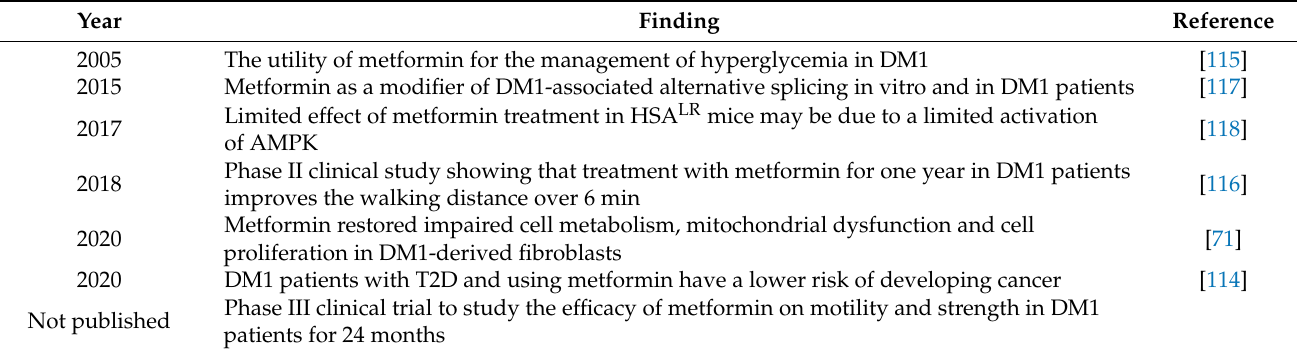
Table 1. Main findings of the effect of metformin on